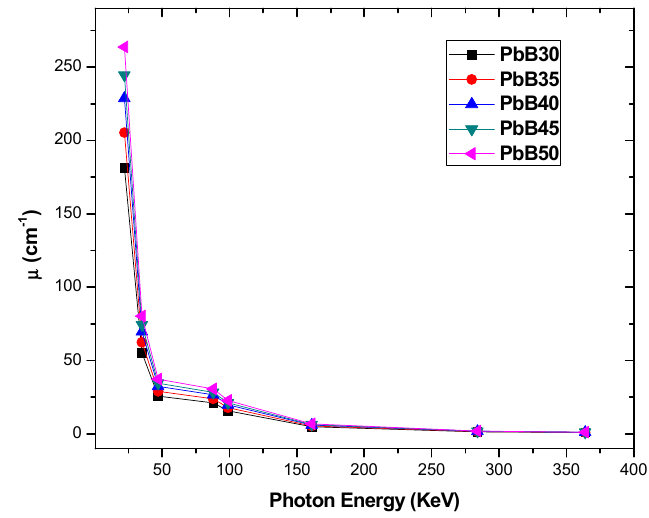
Figure 3. Linear attenuation coefficient µ spectra of PbB30–50 glasses.